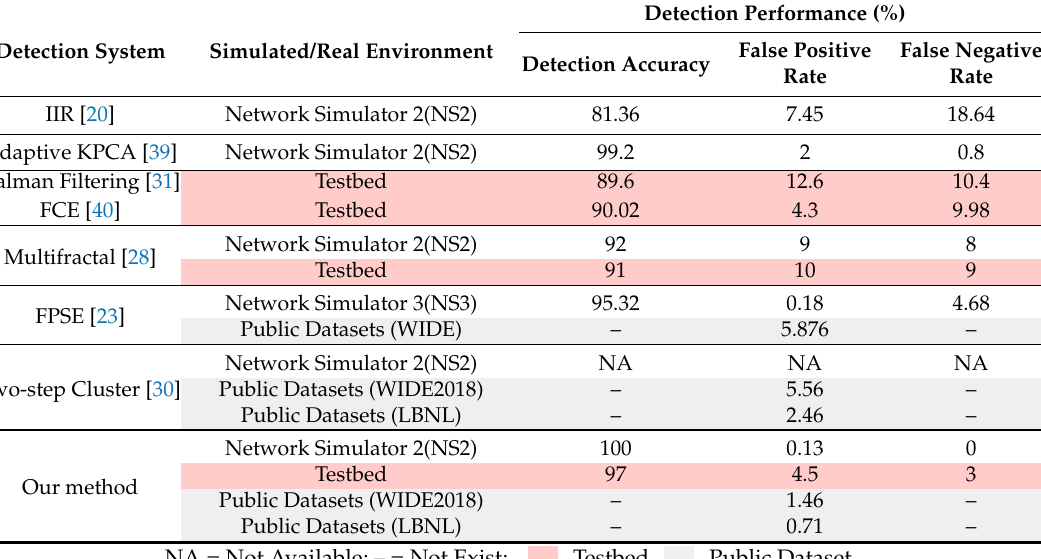
Table 3. Detection performance compared with other